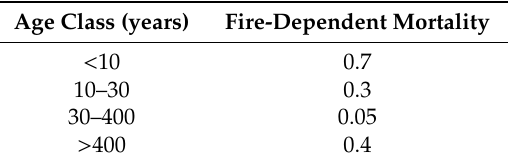
Table A1. Parameters for fire-dependent mortality function MortalityF.